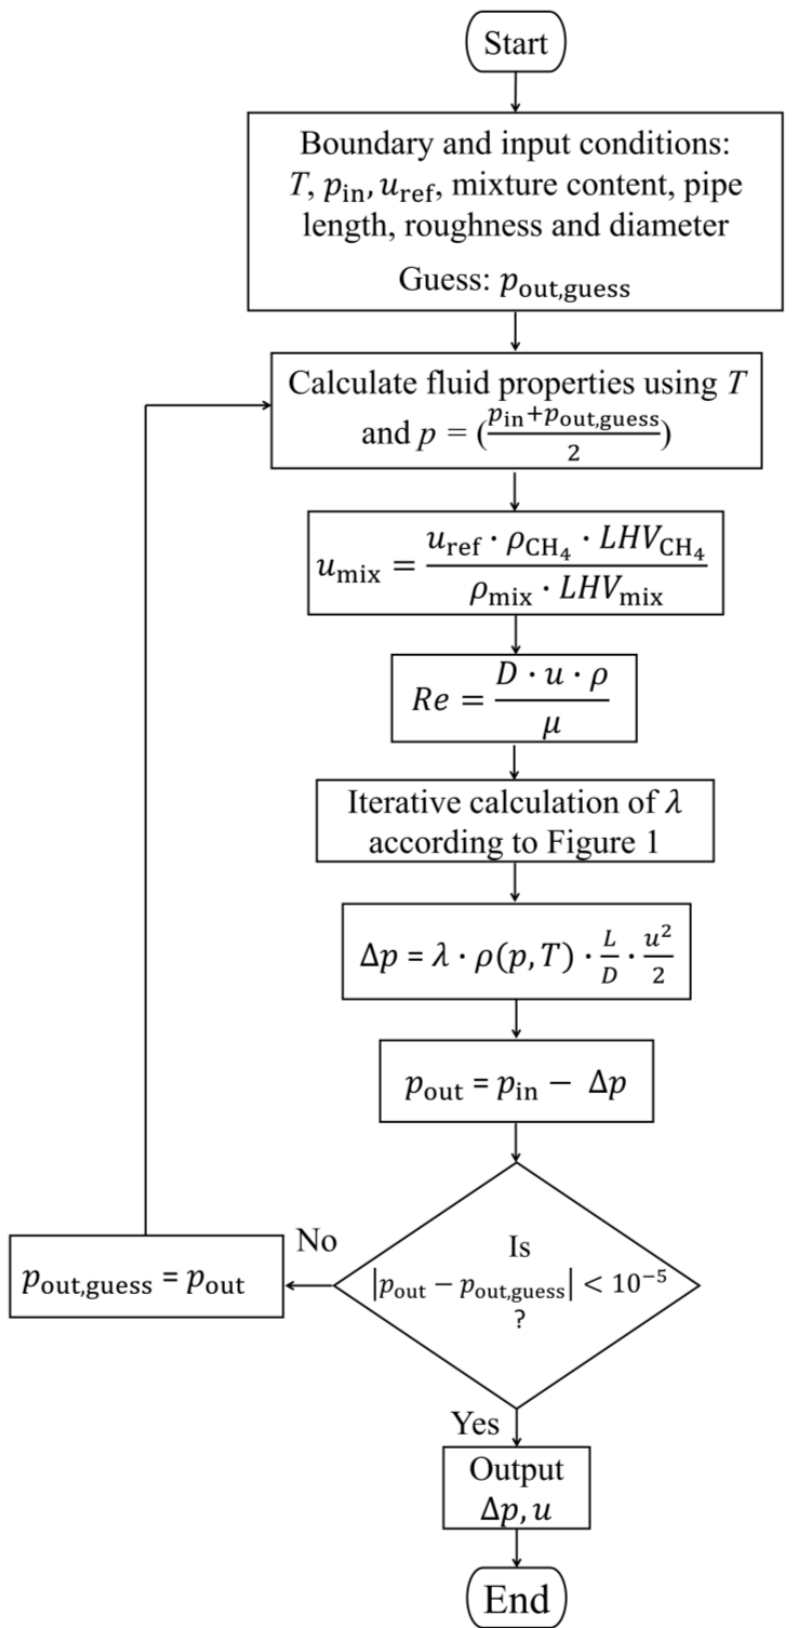
Figure 2. Iterative calculation of the pressure drop in a pipe segment.